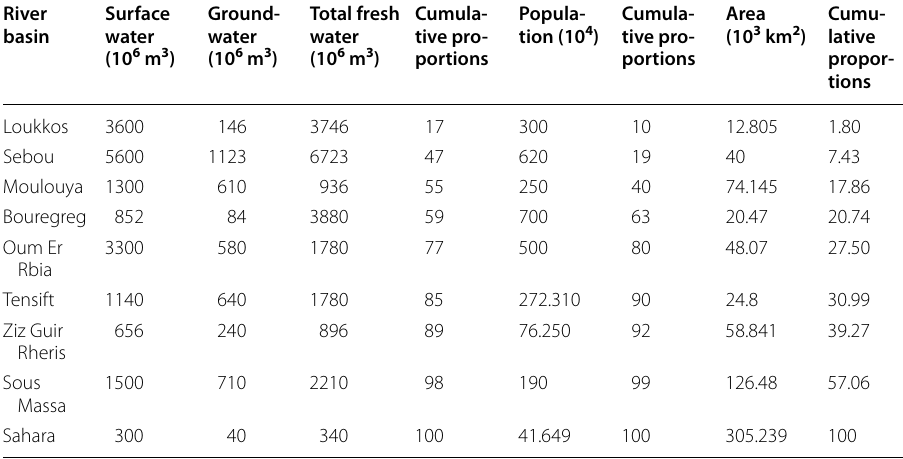
Table 1 Water resources distribution in Morocco. Source : created by the authors with data extracted from the National Water Plan (2013) and the Ministry of Energy, Mines, Water and Environment